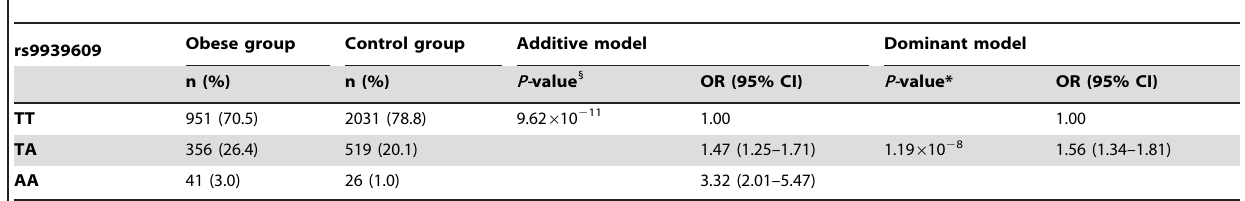
Table 2. Association of the FTO rs9939609 genotype and